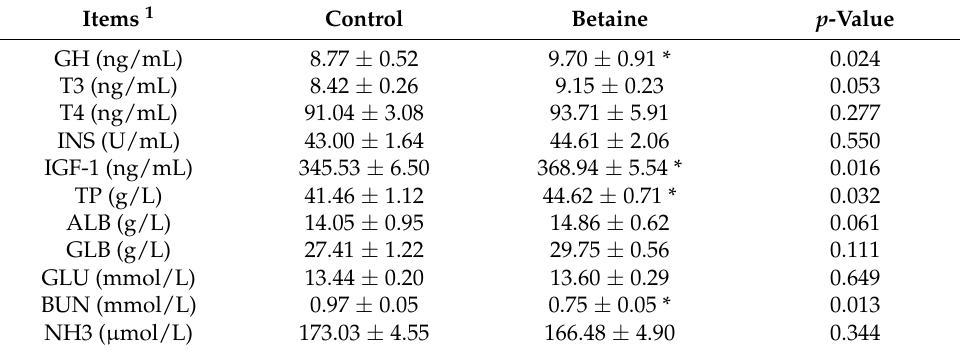
Table 4. Effect of betaine on serum parameters of broilers at 52 d of age. Items 1